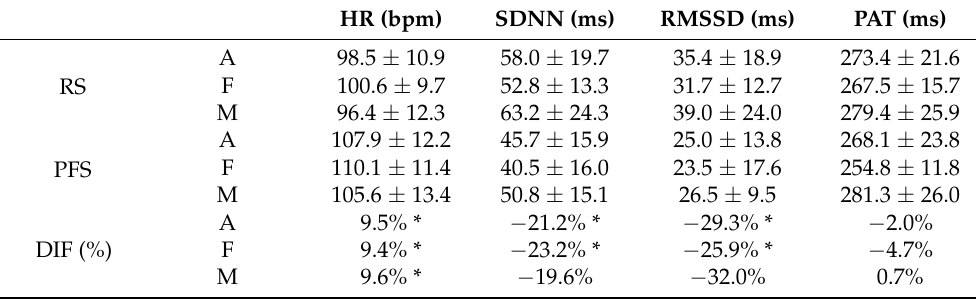
Table 4. Cardiovascular parameter values. Average (mean ± SD) values for the cardiovascular parameters in the rested state (RS), physically-fatigued state (PFS) and their difference (value, %) (DIF). Results are shown for the whole study group (A), female subgroup (F) and male subgroup (M). HR—average heart rate, SDNN—HRV parameter SDNN value, RMSSD—HRV parameter RMSSD and PAT—pulse arrival time. Values marked with asterisk (*) indicate statistical difference (paired t -test, p < 0.05). HR (bpm)